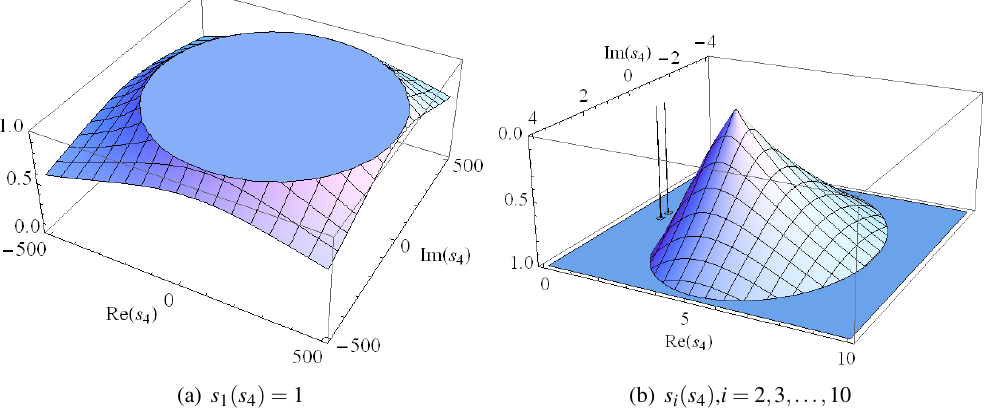
Fig. 1 Stability functions of the strange fixed